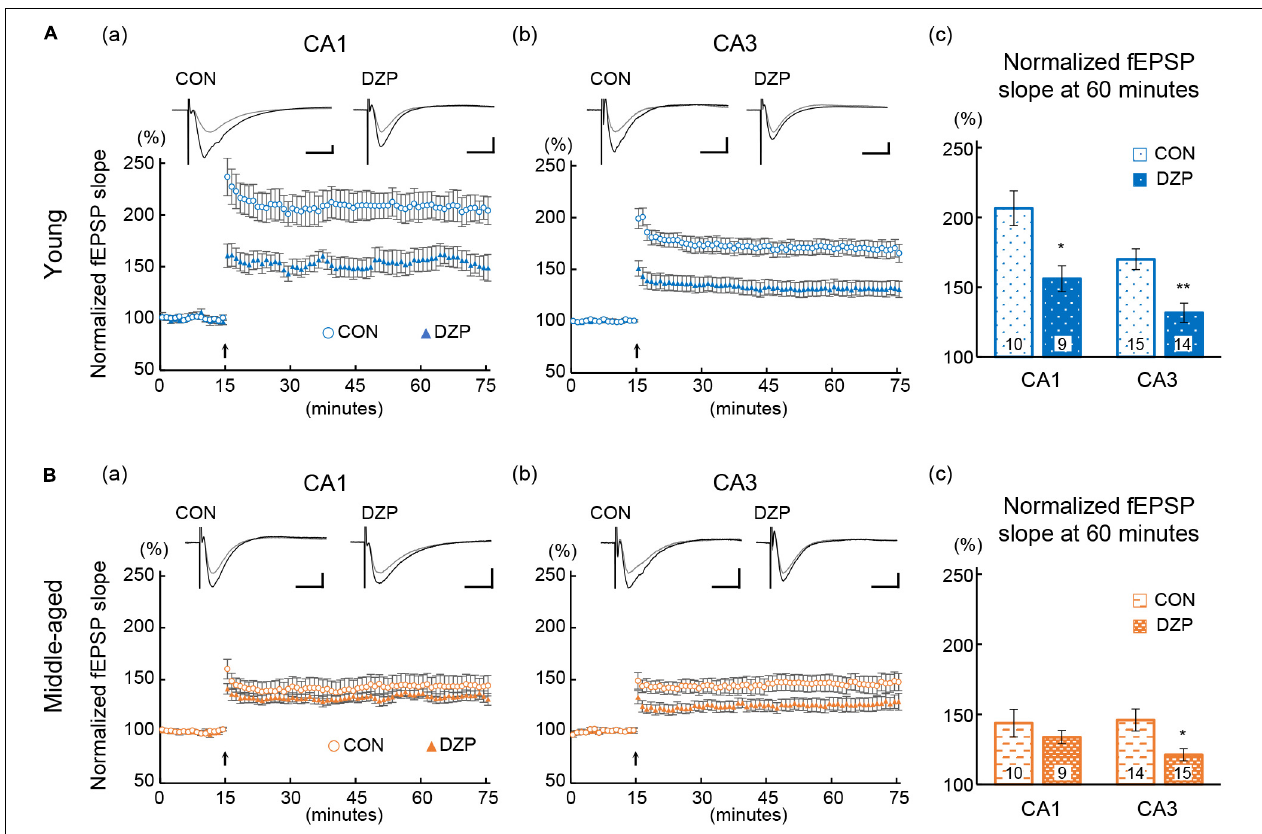
FIGURE 3 | Effects of chronic diazepam administration on long-term potentiation in the hippocampal CA1 and CA3 regions of young (A) and middle-aged (B) mice. Long-term potentiation was induced by TBS at 15 min of recording. The typical fEPSP responses (upper a,b ) from 5 min before (gray) and 45 min after (black) the TBS are superimposed. The peak response of 5 min before TBS was normalized to 100%. Scale bar indicates 0.3 mV/10 ms in (A) and 0.2 mV/10 ms in (B) . The plot shows normalized fEPSP slopes every 1 min. The average normalized fEPSP slopes from the last 15 min were used to compare the magnitude of long-term potentiation between CON and DZP. The number in bar graph indicate the number of recorded slices ( N = 6 animal, 1–3 slices/animal). Error bar: mean ± SEM. * P < 0.05, Student’s t -test; ** P < 0.01, Student’s t -test; vs. CON. CON, control group; DZP, diazepam group; fEPSP, field excitatory postsynaptic